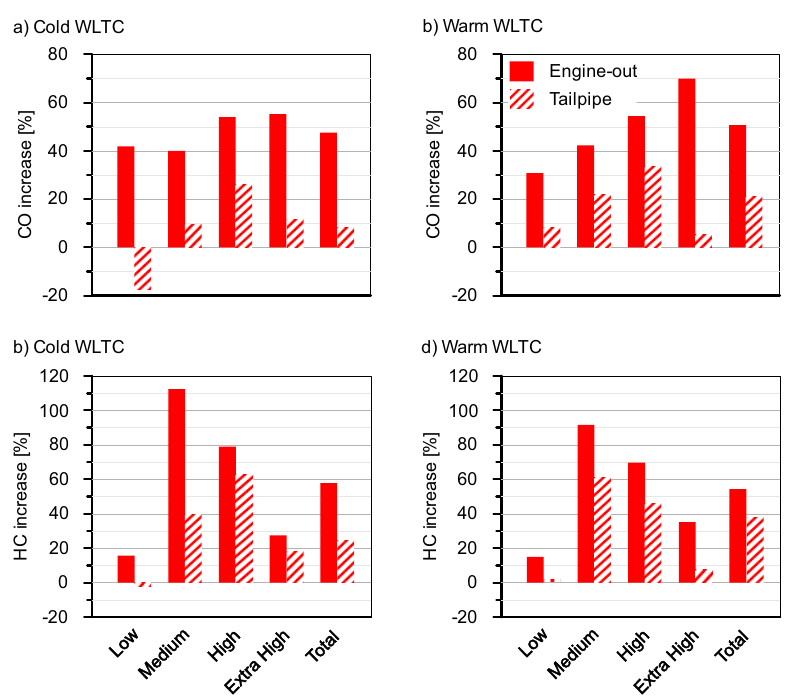
Figure 13. Increment of the CO and HC engine-out and tailpipe emission of the pre-turbine pre-DOC configuration with respect to the baseline ATS configuration in cold and warm WLTCs. ( a ) CO increment in cold WLTC, ( b ) CO increment in warm WLTC, ( c ) HC increment in cold WLTC, ( d ) HC increment in warm